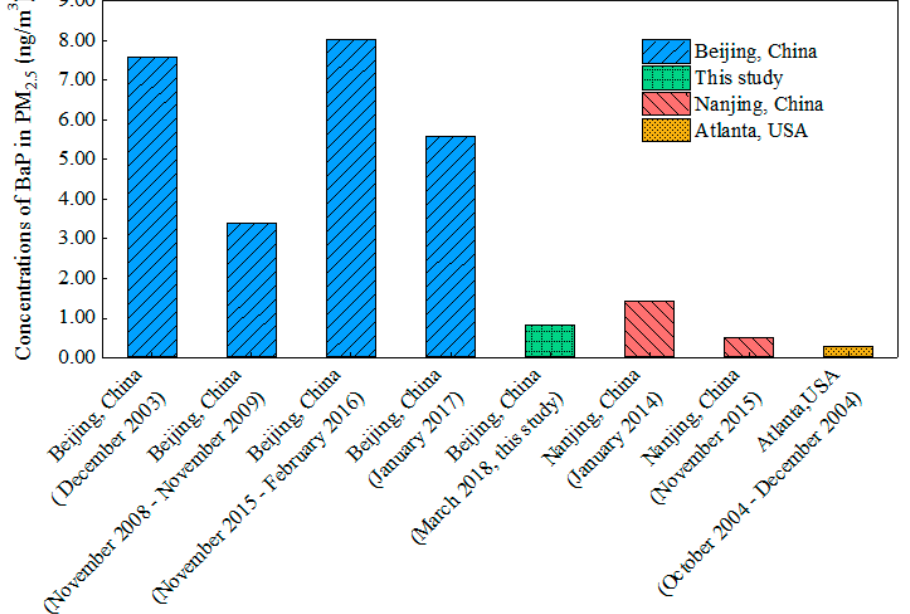
Figure 6. Comparison of BaP mass concentrations in PM 2.5 in the study area with other regions.